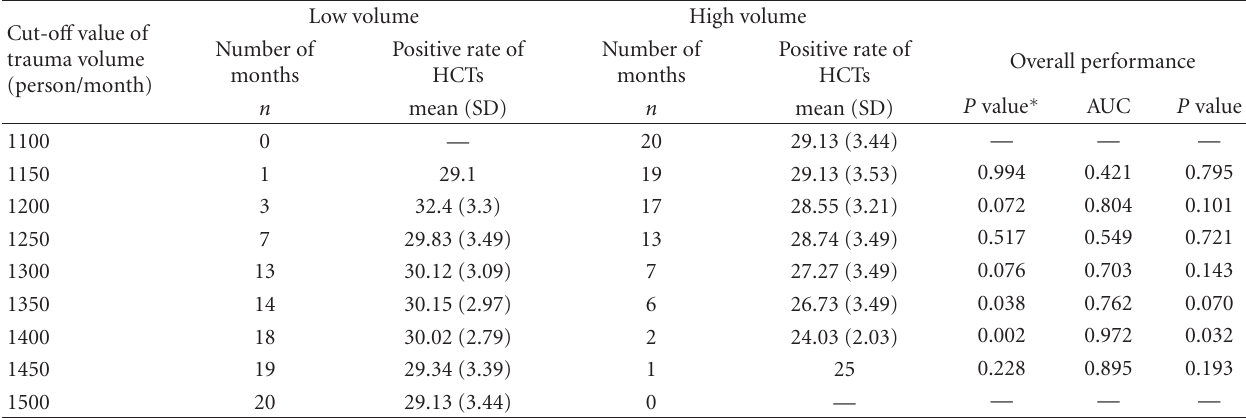
Table 3: Correlation between monthly trauma volume and other survey variables. Cut-o ff value